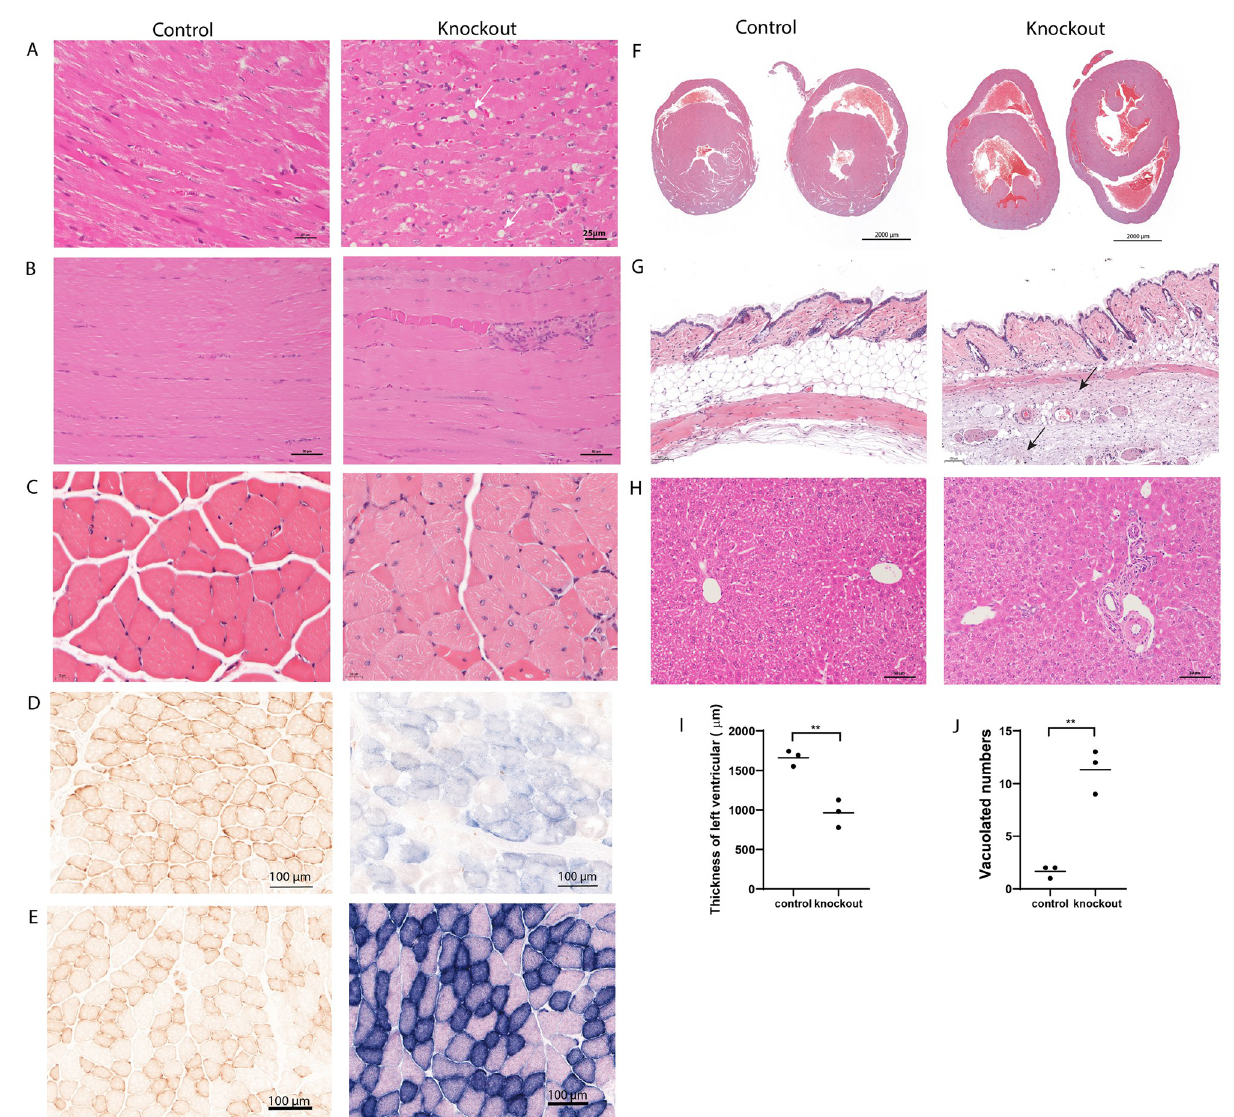
Fig 3. Histology and enzyme activity. (A-C, F-H) Histology results from 16 weeks mice, cardiac muscle (A), skeletal muscle (B), transverse sections of skeletal muscle (C), horizontal view of heart (F), skin (G), and liver (H). COX/SDH staining of control and knockout mice skeletal muscle (D), COX staining control and SDH staining control (E), thickness of left ventricular of control and knockout mice (I), vacuolated numbers in view of 40X of control and knockout mice (J). For (A-J), n = 3 mice per group.